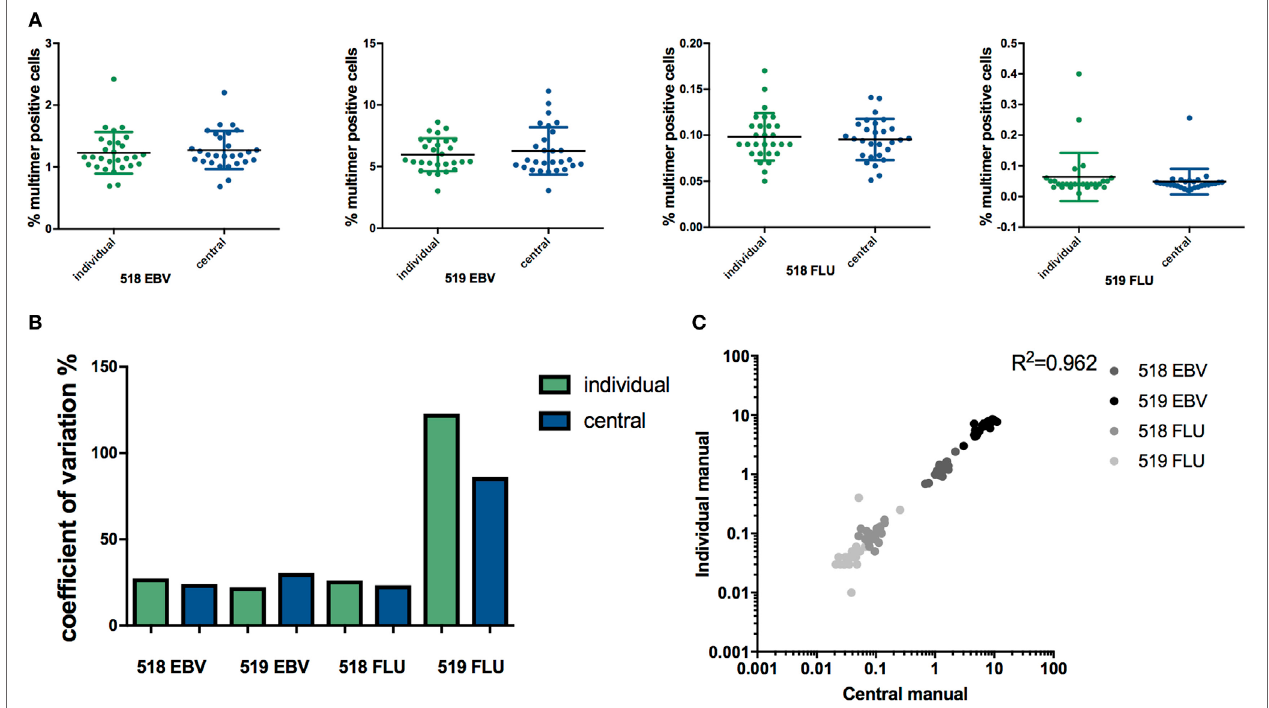
FigUre 1 | Individual versus central manual gating. (a) Percentage of multimer positive cells (EBV or FLU) in total CD8 + T cells in two healthy donors (518 and 519) identified through individual or central manual gating. Each dot represents the mean value for duplicate experiments for an individual lab, n = 28. Line indicates mean and error bars indicate SD. No significant difference between individual gating and central gating was detected (paired t -test). (B) The coefficient of variation (CV = SD/mean*100) related to the identification of major histocompatibility complex multimer positive T cell populations either through individual gating (green) or central manual gating (blue) for the two virus responses and two donors. No differences are statistically significant (asymptotic CV equality test). (c) Correlation of the percentage of multimer positive cells found with individual and manual gating. p < 0.0001 (Pearson correlation), n = 112. Mean values from duplicate experiments are shown. Different colors represent different populations. Individual: gating is done by each individual lab. Central: gating on all files is performed by the same person. 519: healthy donor 519; 518: healthy donor 518; EBV: Epstein–Barr virus; FLU: influenza